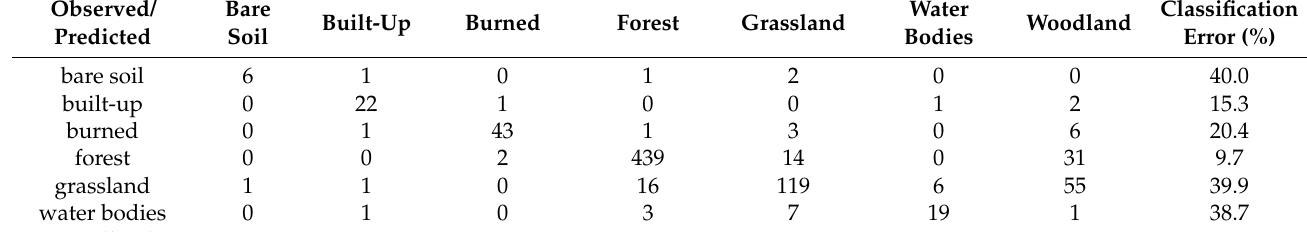
Table 1. Confusion matrix of RF land cover prediction.